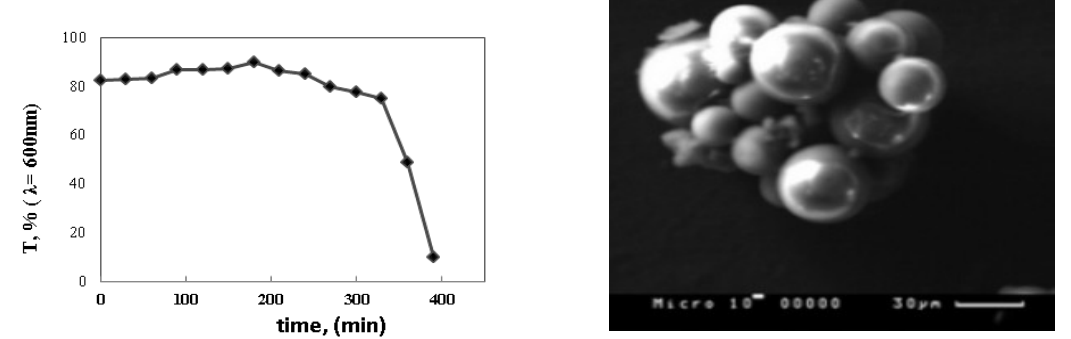
Fig. 1. Time course of turbidity change during the solvent evaporation process (left). SEM image of fabricated nanoparticles (right).